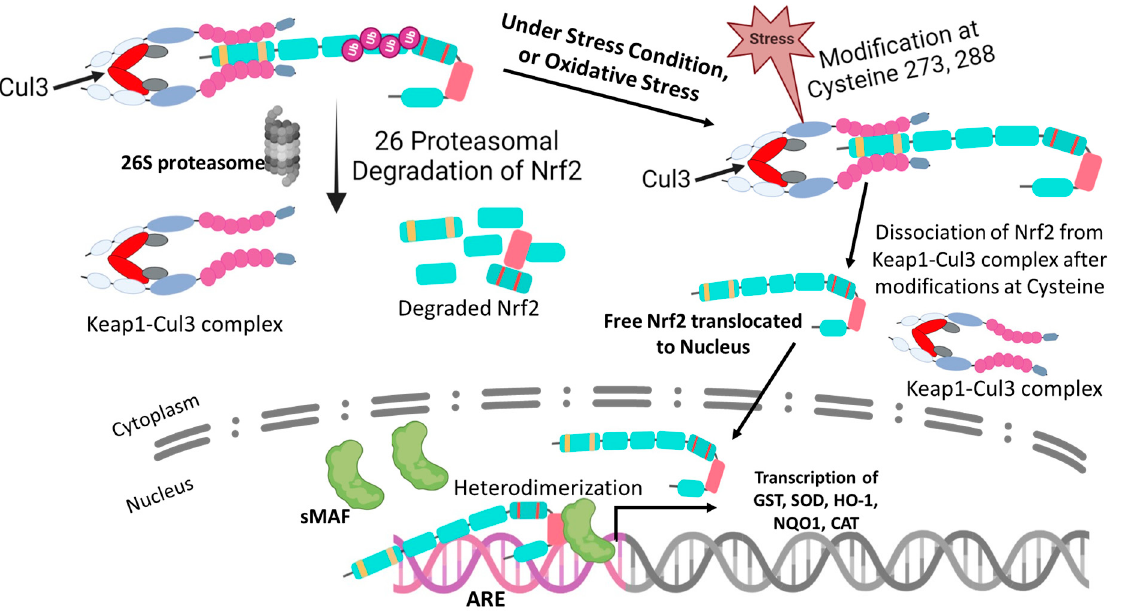
Figure 2. This illustration explains how Keap1–Nrf2 signaling mechanism takes place under both basal and oxidative stress conditions. Under basal conditions, Cul3 and Keap1 heterodimer attaches to Nrf2 and initiates ubiquitination, followed by its 26S proteasomal degradation, which stops nuclear translocation of Nrf2. While under oxidative stress, some of the cysteine residues in IVR domain of the Keap1 are modified that make Keap1 unable to bind with Nrf2. Then, Nrf2 translocates